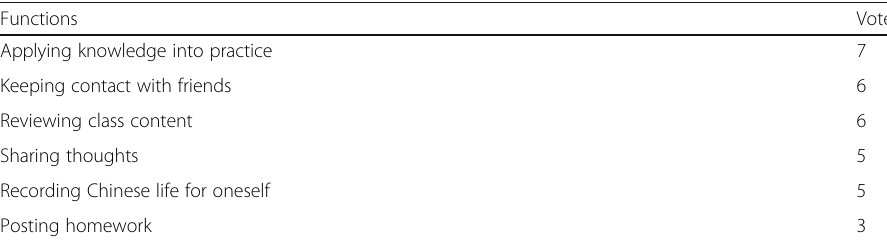
Table 5 Ways that WeChat Helps Chinese Learning Functions Votes Applying knowledge into practice 7 Keeping contact with friends 6 Reviewing class content 6 Sharing thoughts 5 Recording Chinese life for oneself 5 Posting